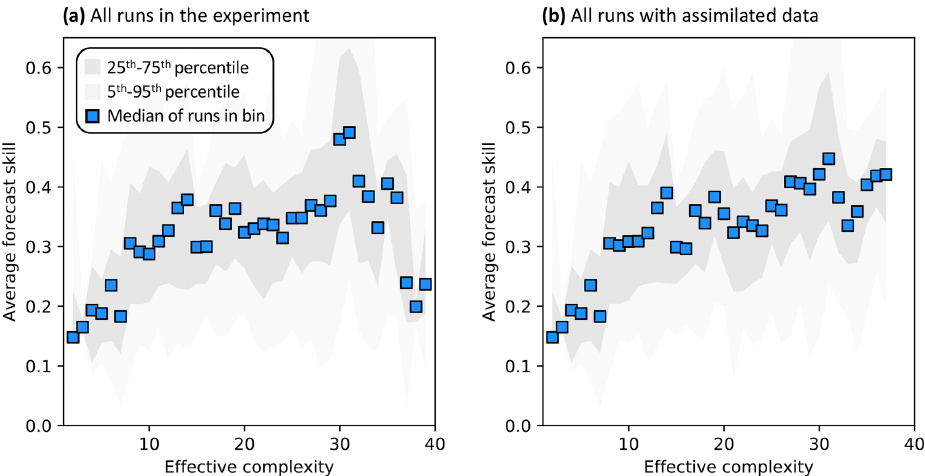
Figure 5. Relationship between effective complexity and NEE forecast skill for (a) all model runs in the experiment and (b) the subset of runs in panel (a) for which data were assimilated. Dark gray shading spans the 25th to 75th percentiles of runs; light gray shading spans the 5th to 95th percentiles; blue points are medians of effective complexity bins. Average forecast skill is computed using the histogram intersection